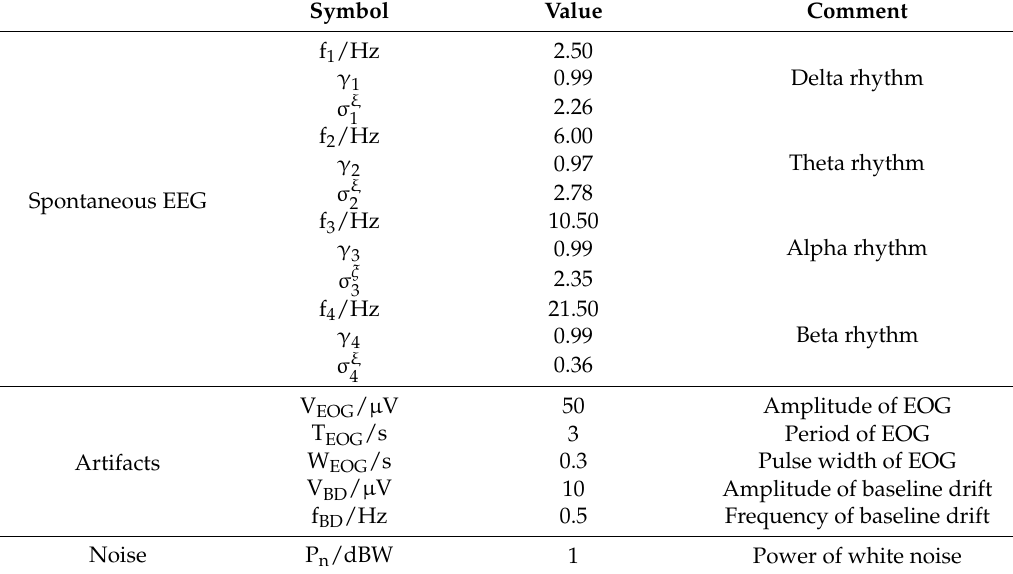
Table 1. Parameters of the simulated electroencephalography (EEG) signal.